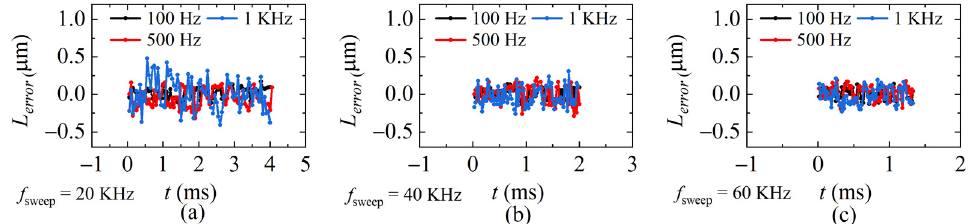
0.41 µ m and the minimum error is 0.001 µ m.